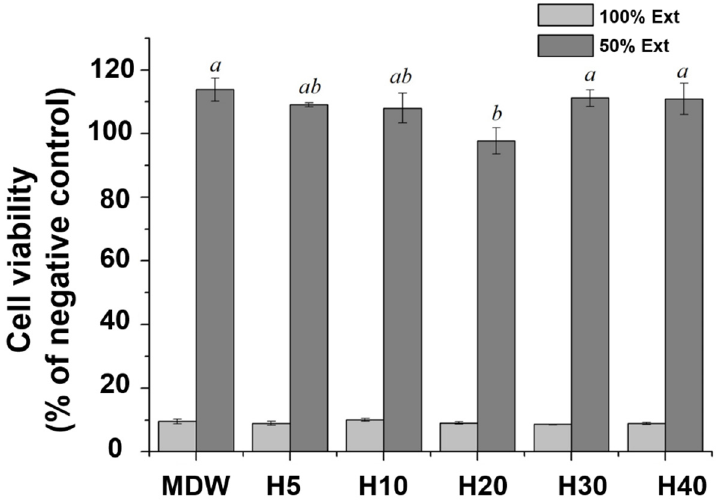
Figure 4. Cell viability of control and experimental groups. The 100% concentration was cytotoxic in all cases, whereas the 50% concentration featured cell viability exceeding 80%. Different small case letters indicate statistically significant differences between the groups with analysis of variance and Tukey’s post-hoc.